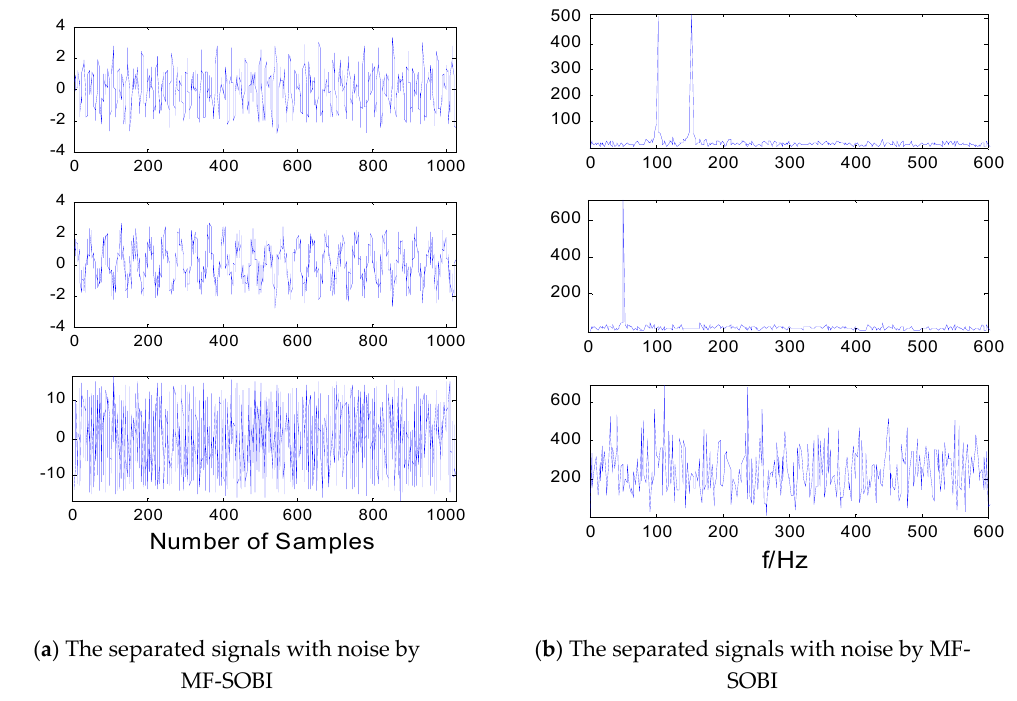
Table 1. Evaluation indexes’ comparison of blind source separation.